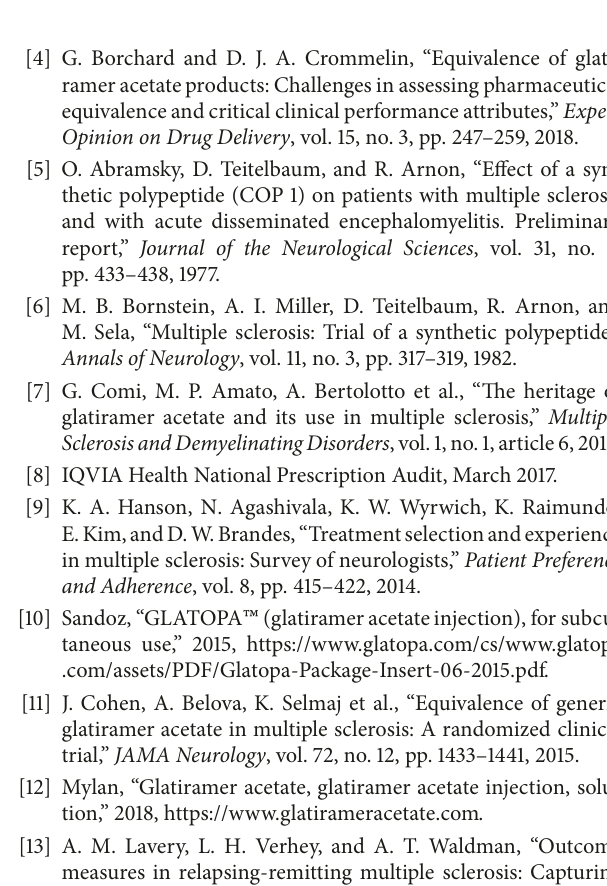
Box 1: Summary of characteristics of branded glatiramer acetate in MS. ARR: annualized relapse rate; DMT: disease-modifying treatment; GA, branded glatiramer acetate; IFN: interferon; MS: multiple sclerosis; PML: progressive multifocal